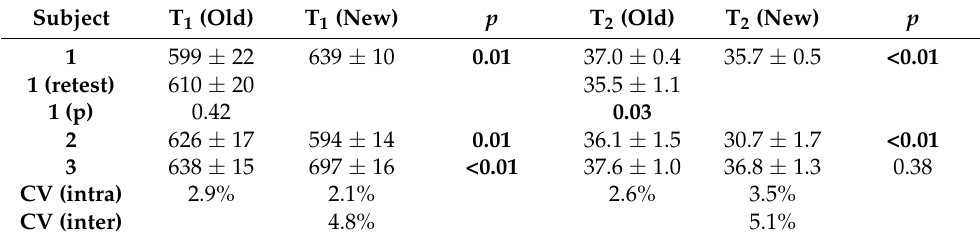
Table 1. Mean and standard deviation of T 1 and T 2 values of white matter obtained from the old and new scanners for each subject as well as intra-scanner and inter-scanner coefficients of variation. p -values correspond to comparisons of T 1 and T 2 values within subjects across scanners (shown in columns) and in test–retest (shown in row 1 (p)). Significant differences ( p < 0.05) are boldfaced. T 1